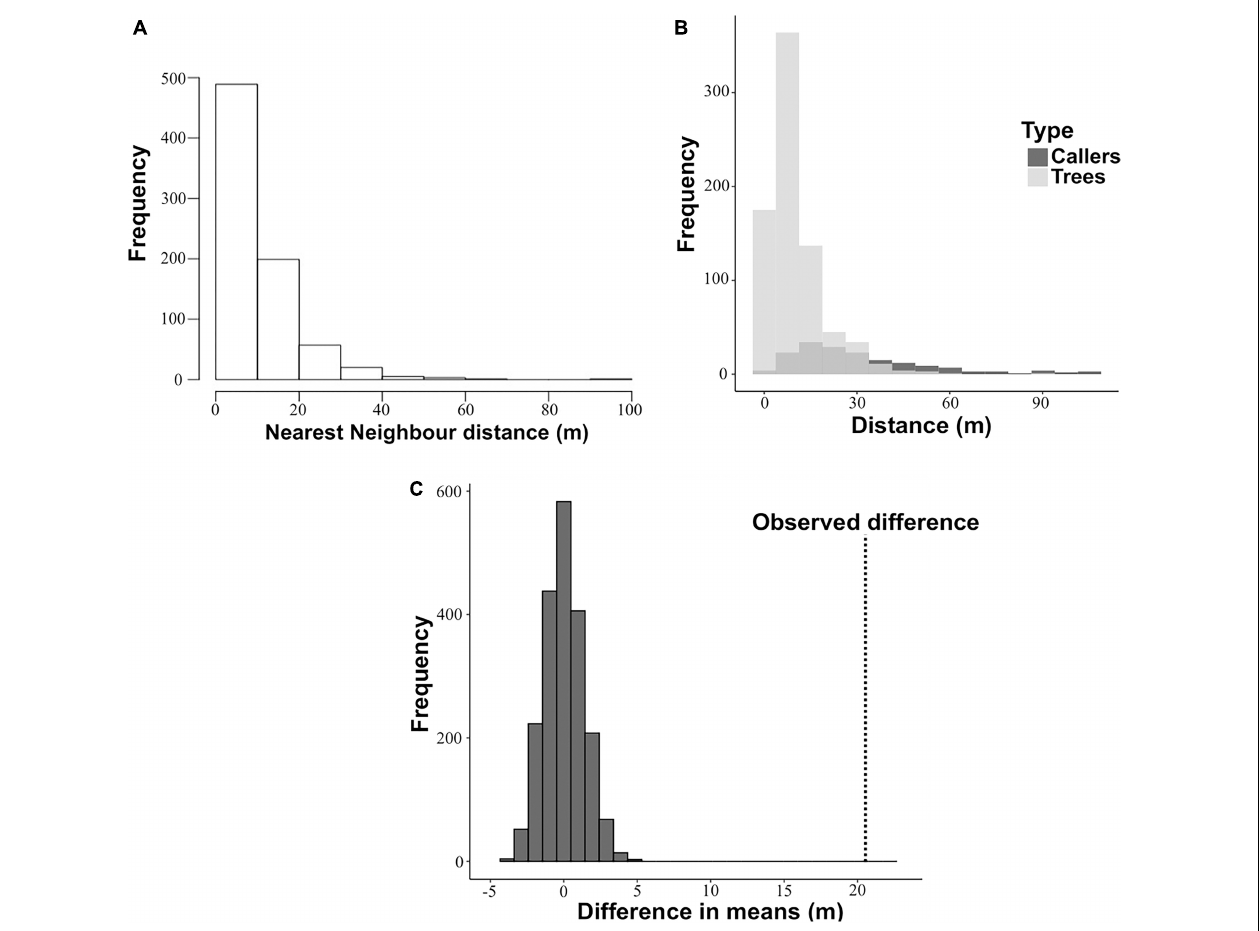
FIGURE 1 | Comparison of nearest neighbour distances of calling males and trees pooled across 16 nights. (A) Distribution of nearest neighbour distances of Artocarpus trees across all plots ( n = 773 trees). (B) Distributions of trees and callers superimposed. (C) Results of randomisation test. The observed difference between the mean nearest neighbour distance of trees and the mean nearest neighbour distance of callers is marked on the plot by the vertical dotted line.